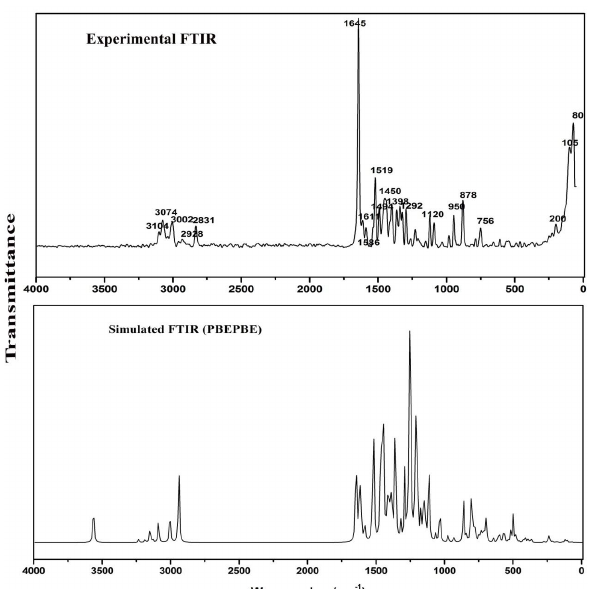
Figure 6: Experimental and simulated (PBEPBE) FT-IR spectra of